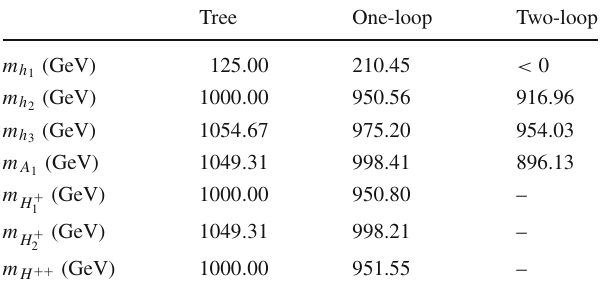
Table 6 The scalarmasses at tree and loop level for the parameterpoint λ